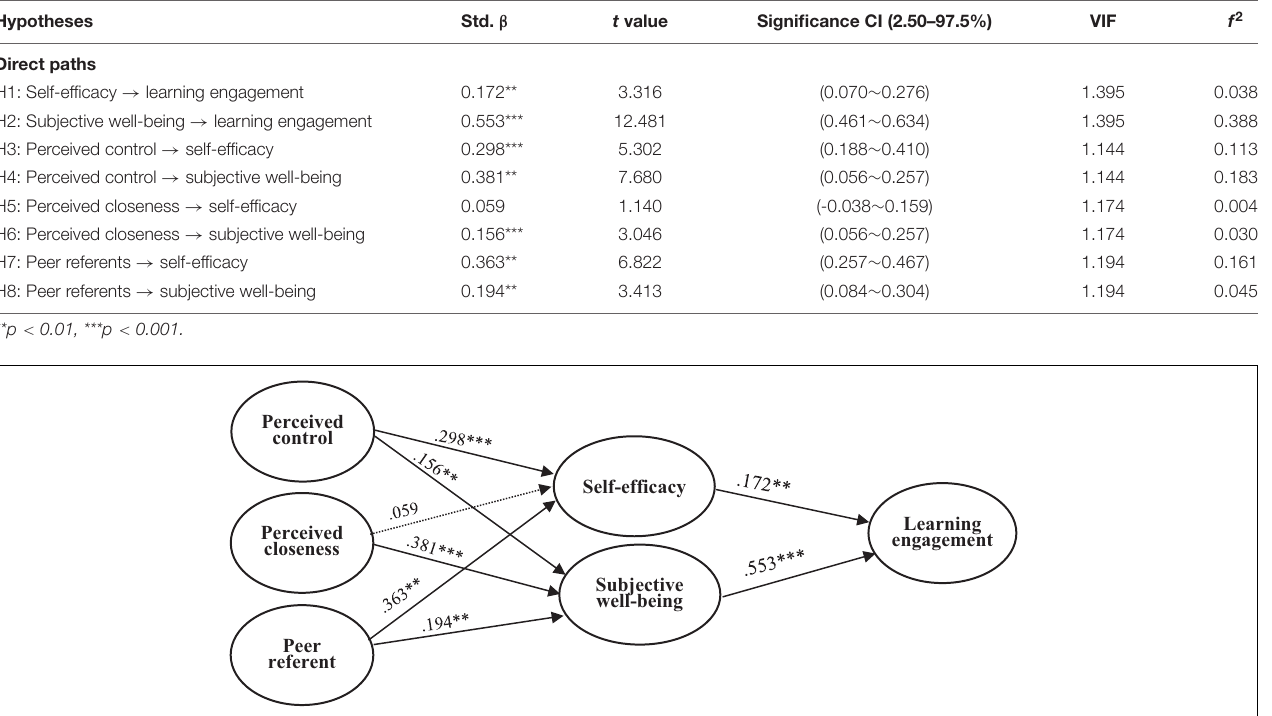
TABLE 3 | Results of the hypotheses testing.